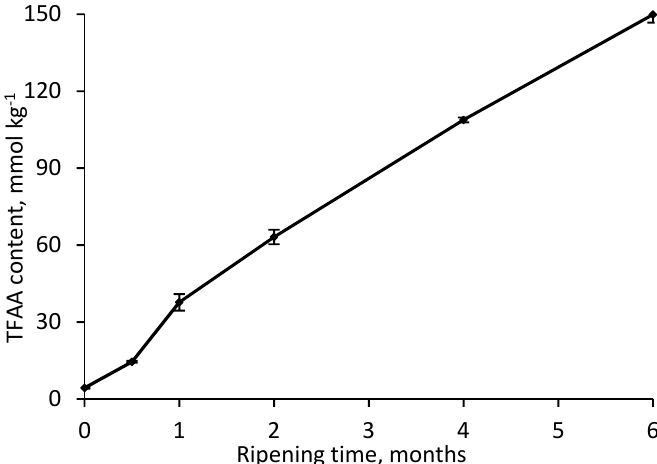
Figure 3. The change in total free amino acids (TFAA) content during RO-cheese ripening.